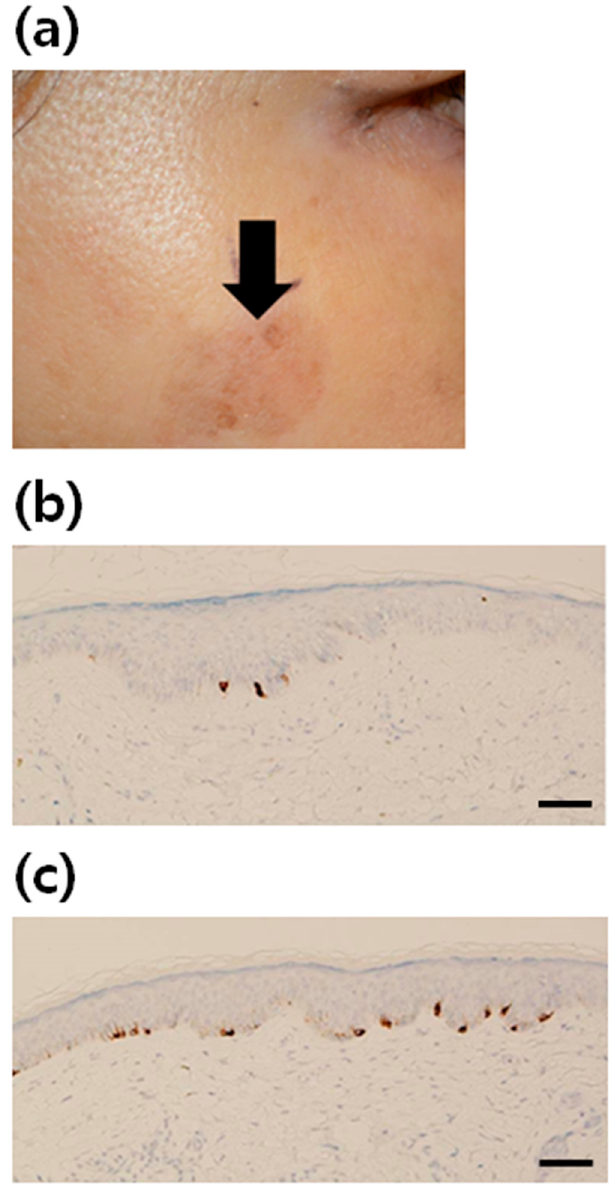
Figure 1. Increment of melanocytes in solar lentigo (SL) tissue. ( a ) A clinical photograph of facial SL. Immunohistochemical staining using antibodies to Melan A (brown color) in ( b ) normal skin (×200) and ( c ) SL (×200). The number of melanocytes was increased in the lesional skin of SL, compared with that in the non-lesional skin (scale bar: 50 µm).